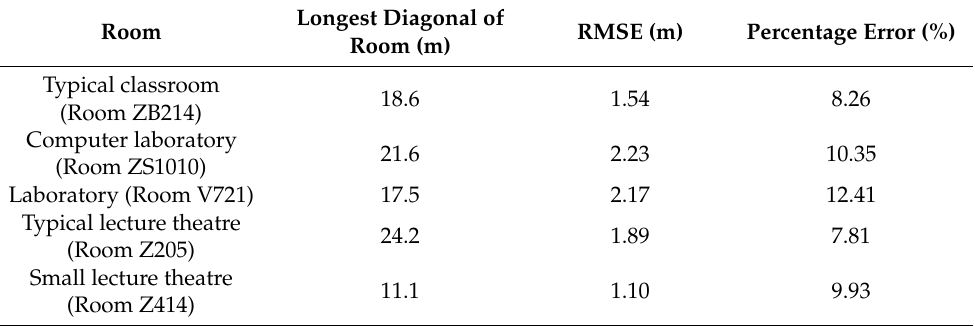
Table 3. RMSE and percentage error results of the venue